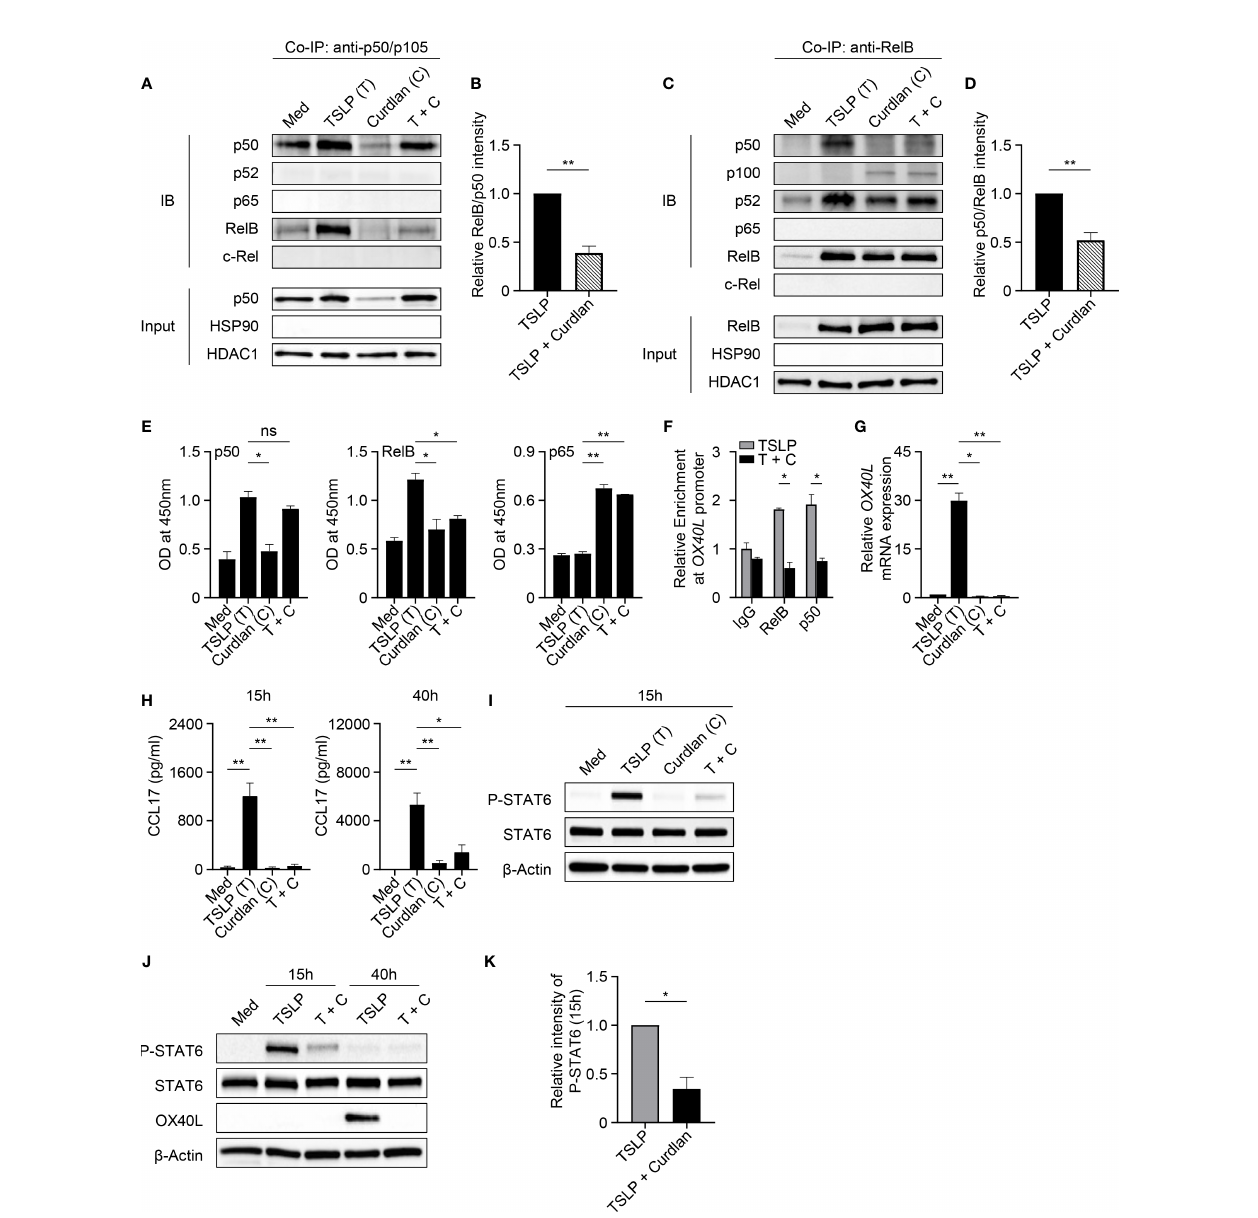
FIGURE 4 | Dectin-1 Stimulation Inhibits TSLP-Induced OX40L and CLL17 Expression. (A – D) Nuclear proteins from mDCs treated with Med, TSLP and/or curdlan for 40h were used for Co-IP assay. Anti-p50/p105 (A, B) or anti-RelB (C, D) was used as pull-down antibody. Proteins in the immunoprecipitants were analyzed by immunoblotting (IB). In input controls of nuclear proteins, HDAC1 was probed as loading control and HSP90 was probed to investigate the possible cytoplasmic contamination. Representative Western blot data (A, C) and summarized data (B, D) from three independent experiments are shown. The intensity of co- immunoprecipitated protein RelB (A, B) or p50 (C, D) was fi rst normalized to that of IP protein p50 (A, B) or RelB (C, D) in immunoprecipitants, and then relative intensity in TSLP + Curdlan (T + C) group was obtained by comparison with TSLP group. (E) DNA binding of NF- k B subunits in nuclear extracts of mDCs from different donors (n = 3) treated with indicated reagents was measured by ELISA. (F) ChIP assay demonstrates the relative enrichment of RelB and p50 at the region around the k B-like sequences of OX40L promoter in response to TSLP or TSLP and curdlan (T + C). Summarized data from three independent experiments are shown. (G) Quantitative PCR for OX40L mRNA in mDCs from different donors (n = 3) after incubation with indicated reagents for 40h. OX40L expression is normalized to GAPDH and set at 1 in mDCs cultured in Med. (H) CCL17 in culture supernatants of mDCs (n = 4) after incubation with indicated reagents for 15h or 40h was measured by ELISA. (I – K) Whole cell lysates of mDCs incubated with indicated reagents for 15h or 40h were used for immunoblotting. Representative Western blot data (I, J) and summarized data (K) from different donors (n = 3) after 15h stimulation are shown. The intensity of P-STAT6 was fi rst normalized to that of STAT6 in the same group, and then relative intensity was obtained by comparison with Med group. Data in (B, D – H, K) are represented as mean ± SD. Signi fi cance was determined using paired t test (two-tailed) for (B, D, K) and one-way ANOVA with Tukey multiple comparisons test for (E, G, H) , and two-way ANOVA with Tukey multiple comparisons test for (F) . * p < 0.05, ** p < 0.01 for the comparison between groups. ns, not signi fi